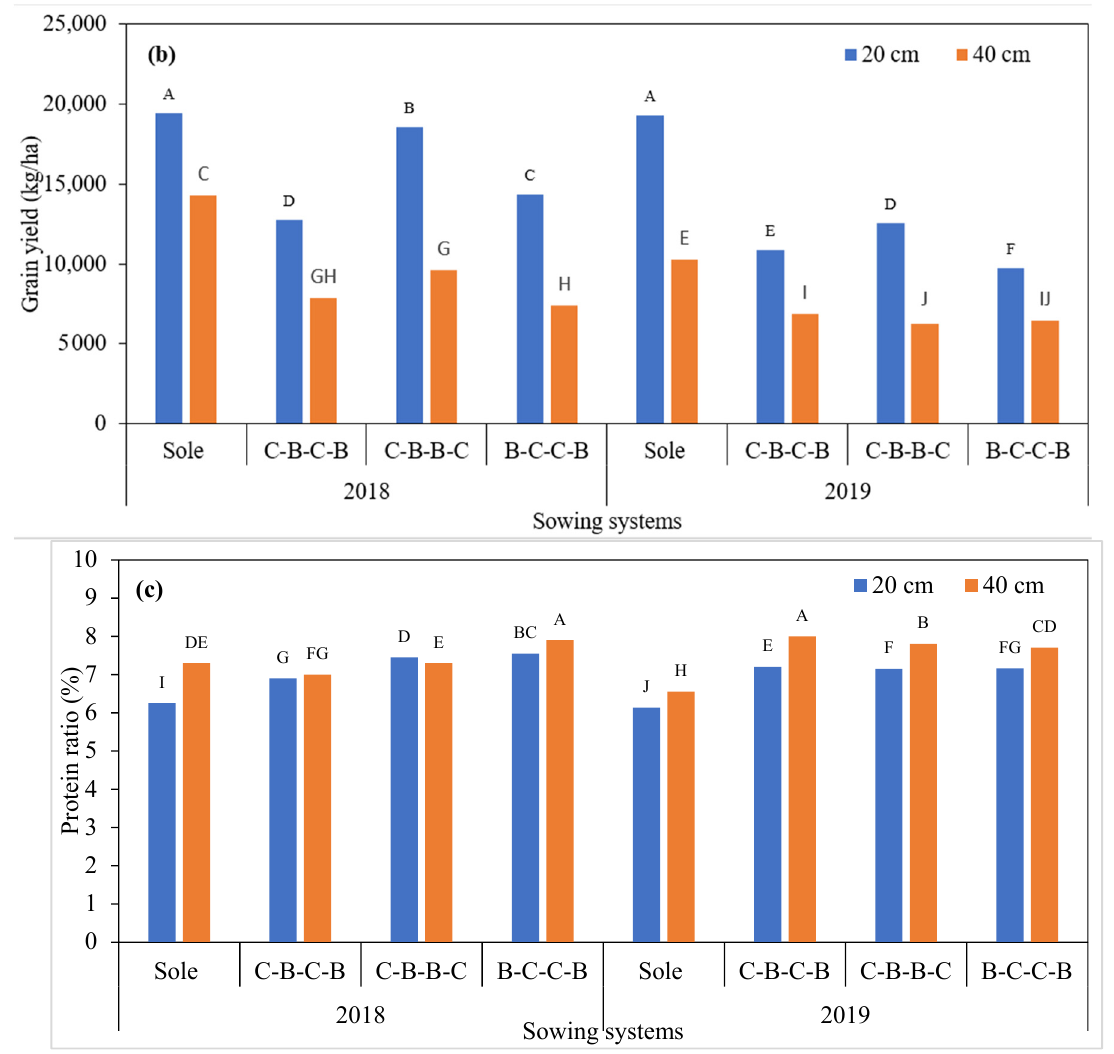
Figure 5. The interactions of maize-white bean sowing systems on 1000-kernel weight ( a ), grain yield ( b ) and protein ratio ( c ) at Nur Sultan, Kazakhstan research station. Letters on each bar represent a significance level at p < 0.01. Note: different letters denote significant differences, while the same letters indicate insignificantly different